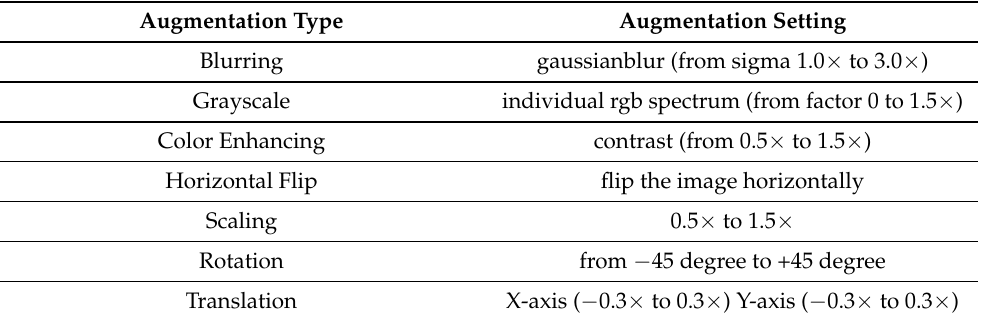
Figure 6. Sample of data augmentation of one image. Table 4. Augmentation types and